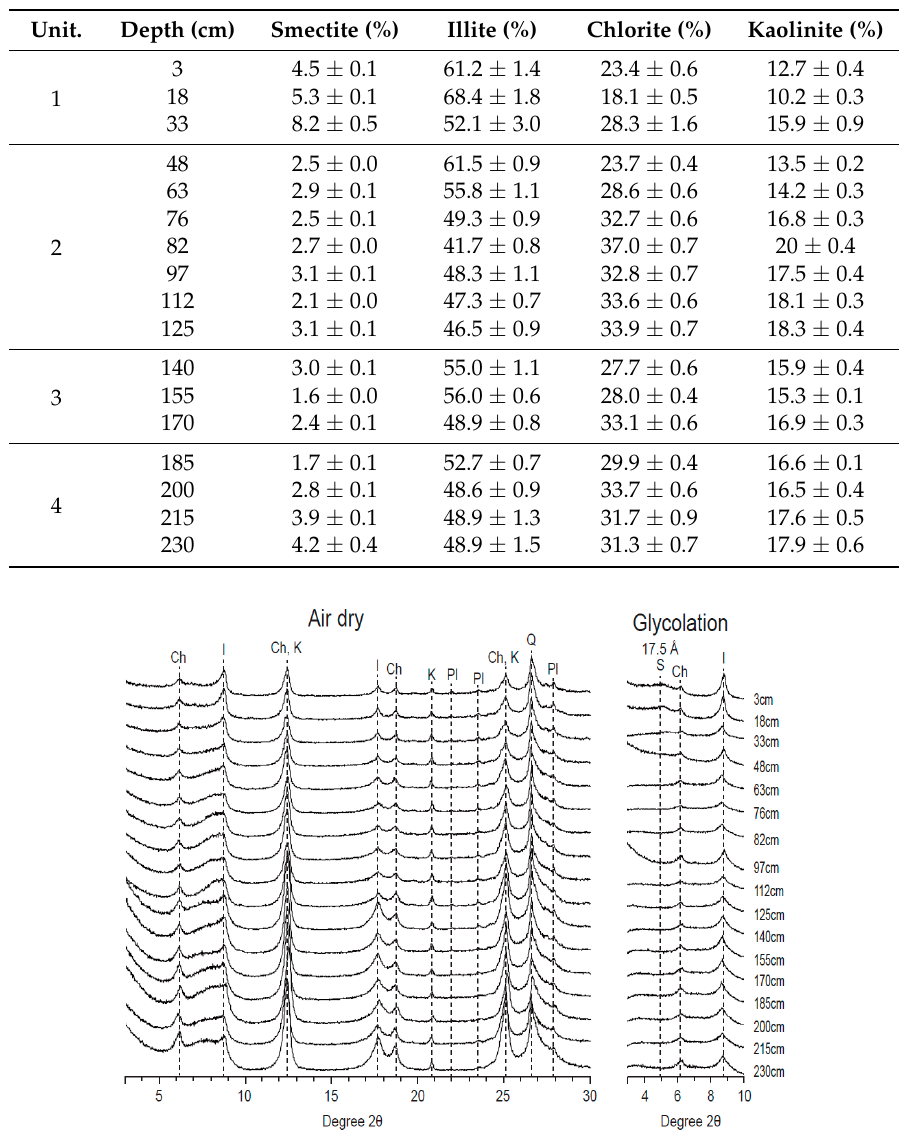
Figure 3. X-ray diffraction (XRD) patterns of air-dried and glycolated clay (<2 µm) in sediment core from site EAP13-GC17 at various depths (S: smectite, Ch: chlorite, K: kaolinite, I: illite, Pl: plagioclase, Q: quartz) . Table 1. Relative abundance of clay minerals in the EAP13-GC17 core . Unit.